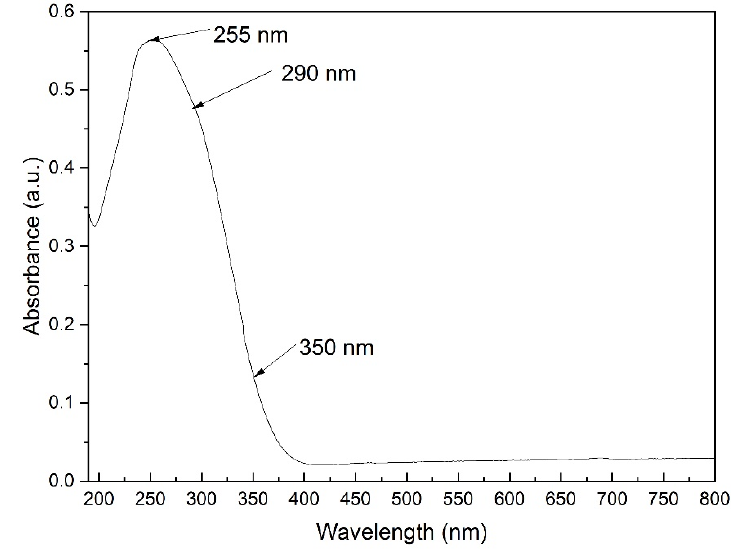
Figure 8. The UV–Vis spectrum of the Ti-MCM-41 catalyst. Figure 8. The UV-Vis spectrum of the Ti-MCM-41